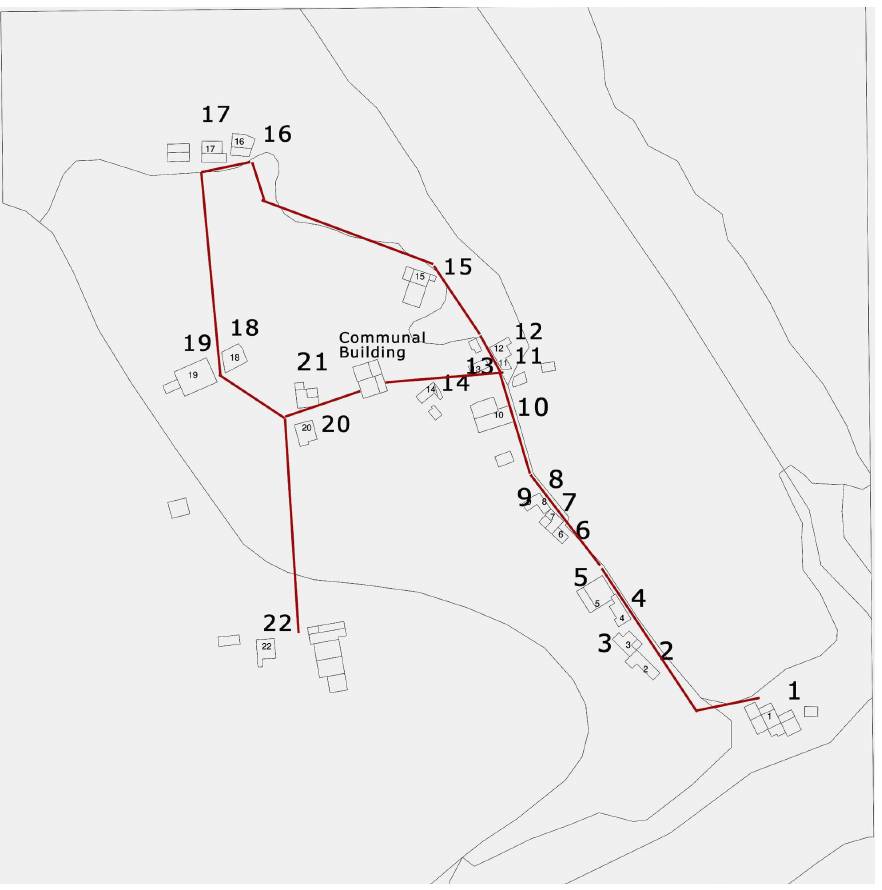
Figure 4. LMRA microgrid map.The interconnection of the 21 SHSs (Houses 3 and 4 have a common AC connection) and community assets. In the middle is the communal building/assets from which two interconnection lines start, one of which works as a